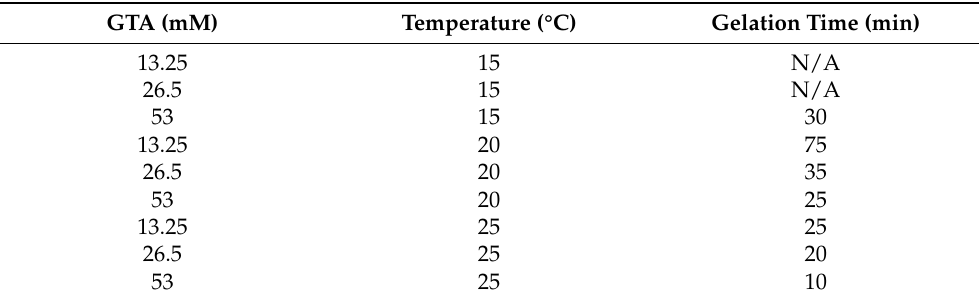
Table 1. Gelation times of gels produced with different concentrations of GTA and held at different gelation temperatures. Adapted from